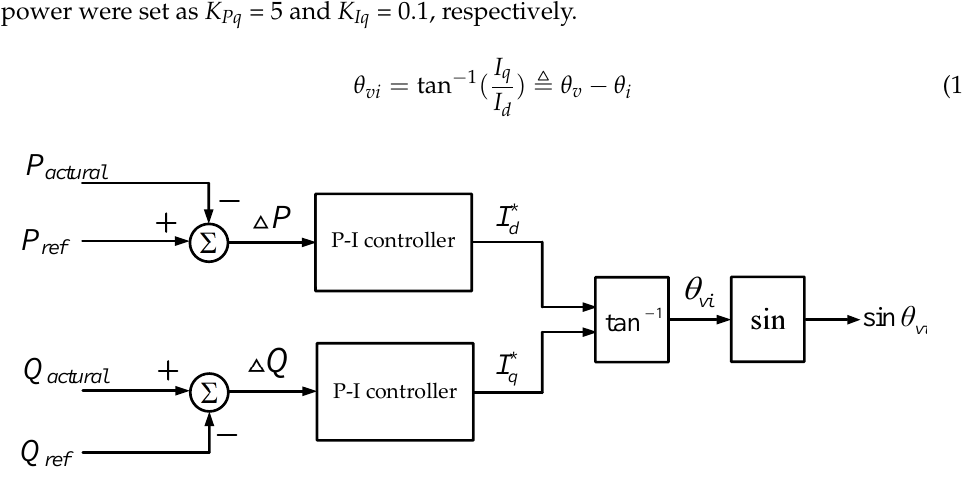
Figure 8. The control scheme for the phase angle of the smart inverter.